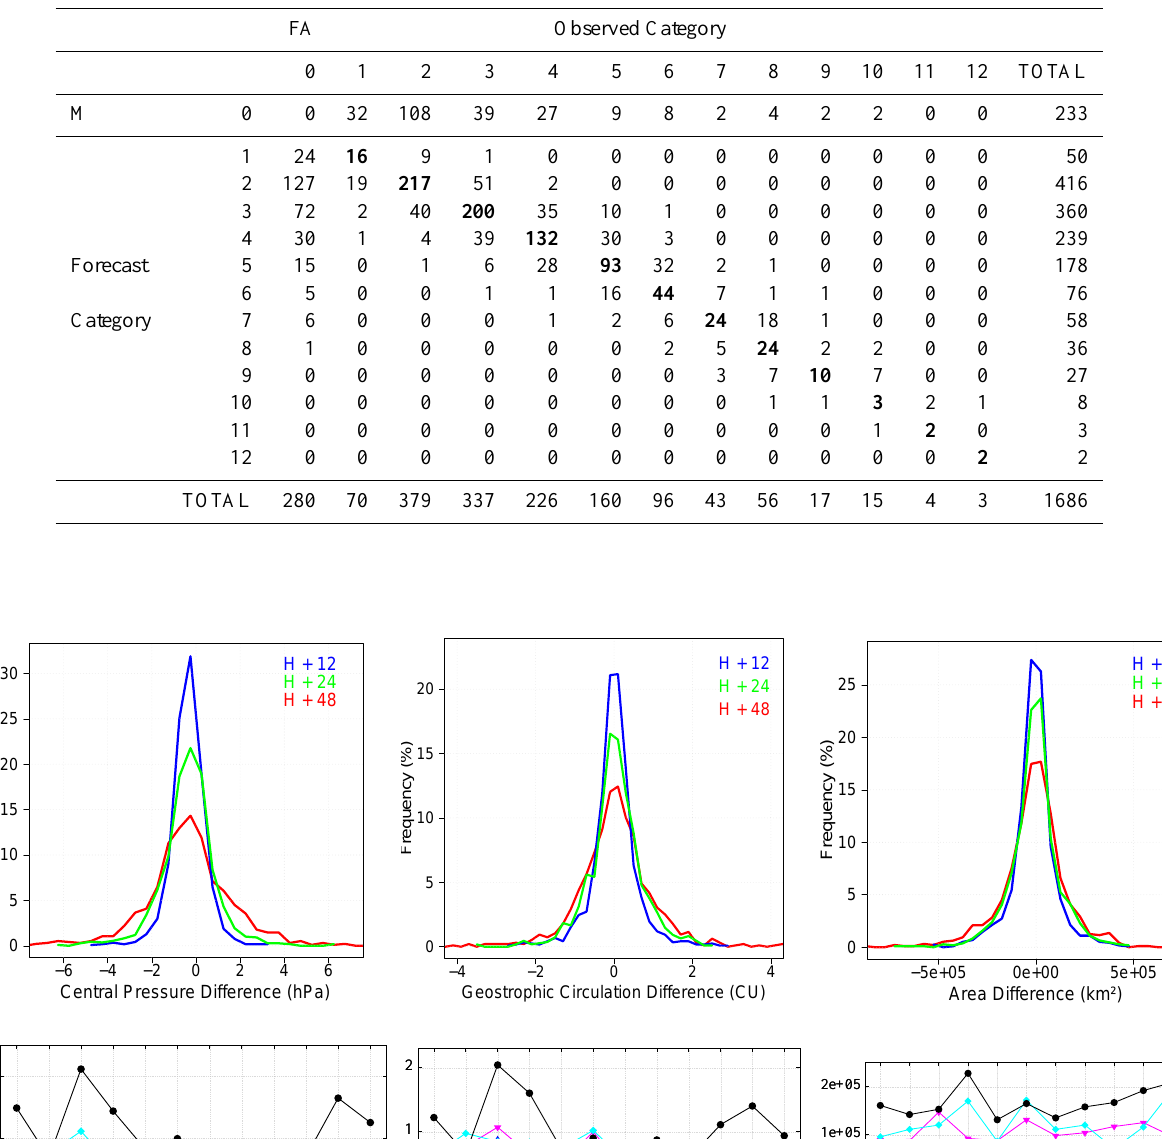
Table 2. Multi-category contingency table for the forecast range H+12. The cyclones were categorized according to their intensity. Twelve categories of 1 CU were defined. False Alarm distribution appears at the zero observed category column (FA). Miss distribution appears in the zero forecast category row (M).